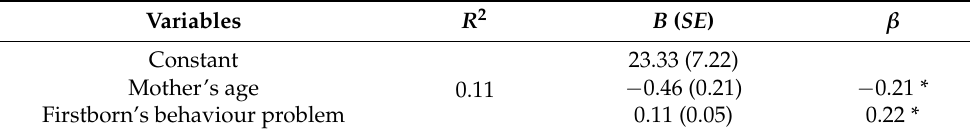
Table 3. Regression of second-time mother’s prenatal depression ( N = 105).